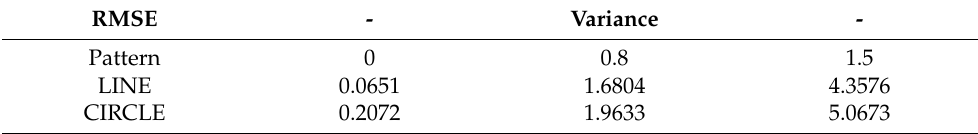
Table 1. SMEs in different noise levels for LINE and CIRCLE patterns.